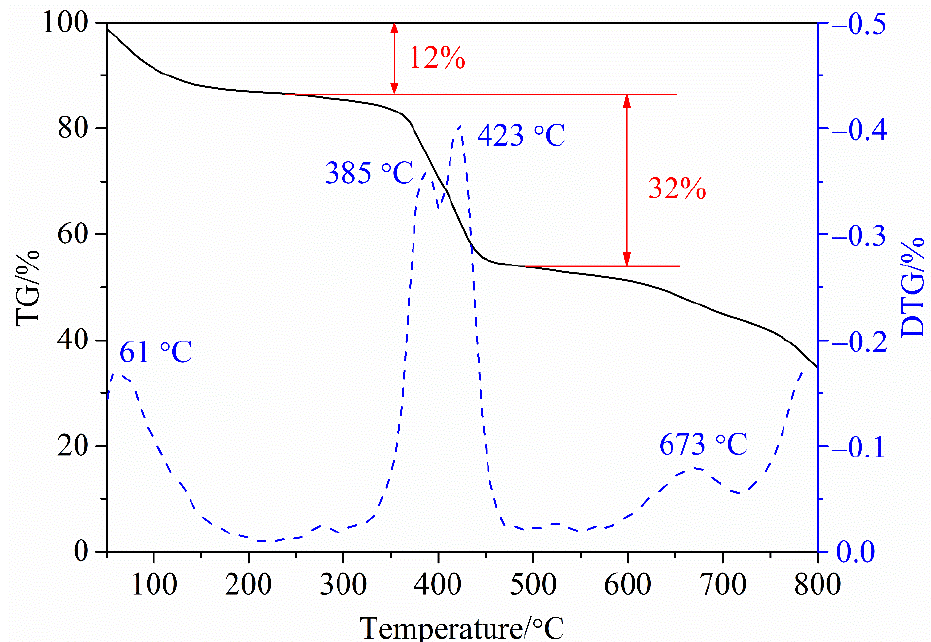
Figure 3. Thermogravimetric analysis curve of LDMS.